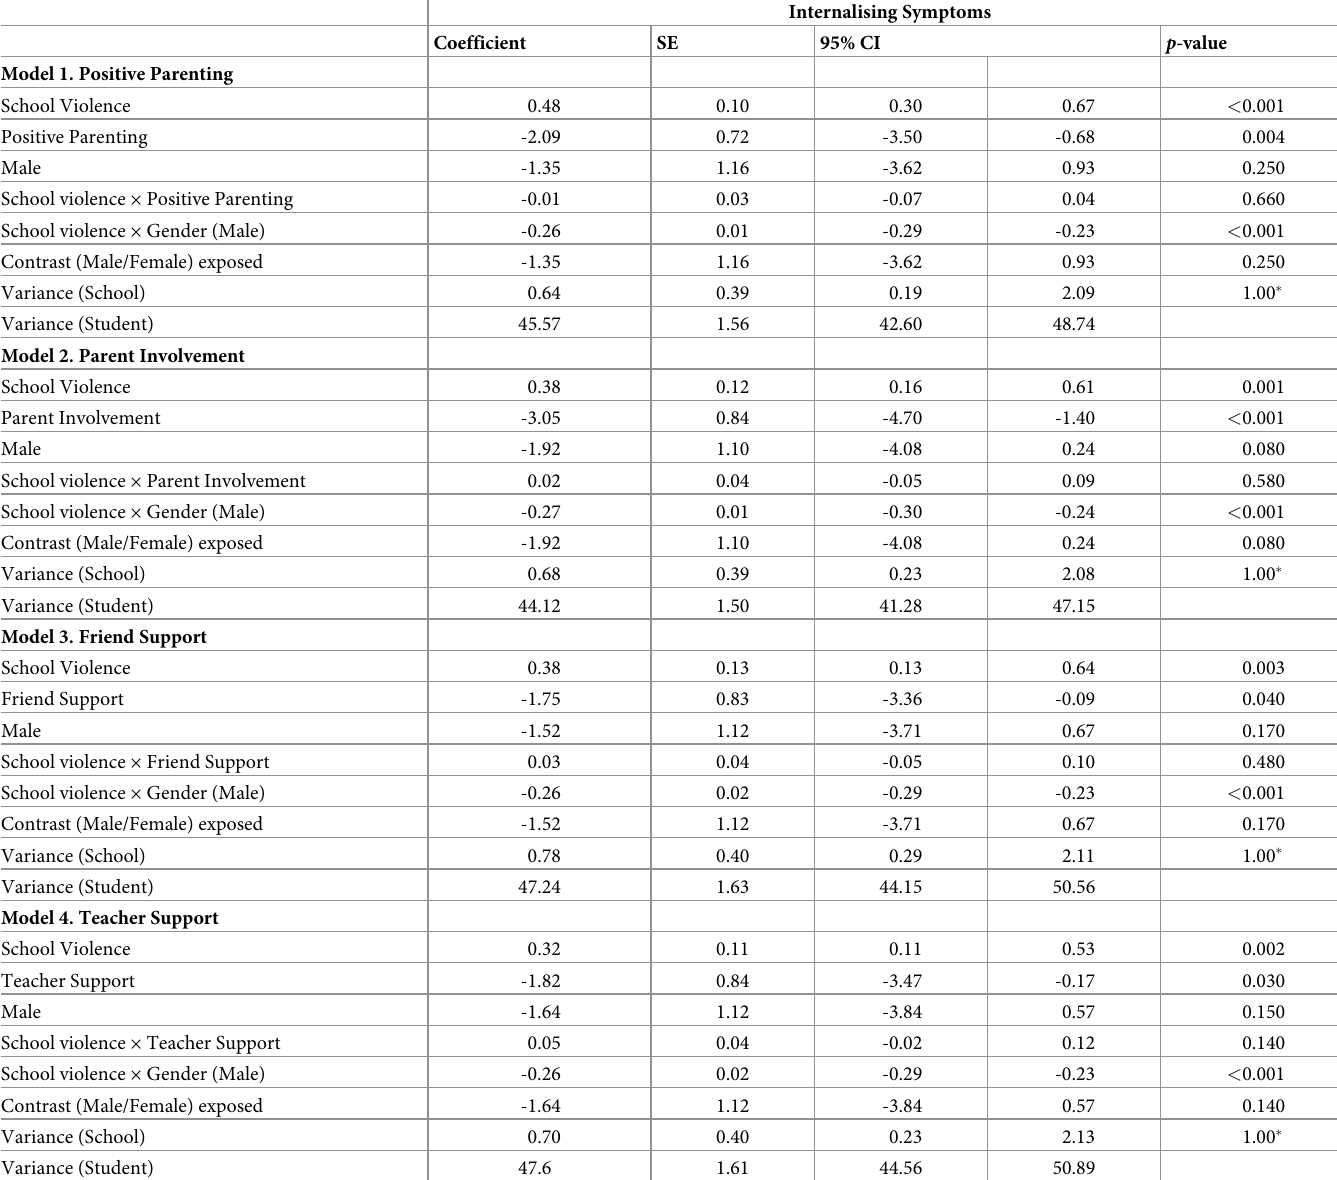
Table 5. Linear mixed-effects models of school violence, type of social support & interactions